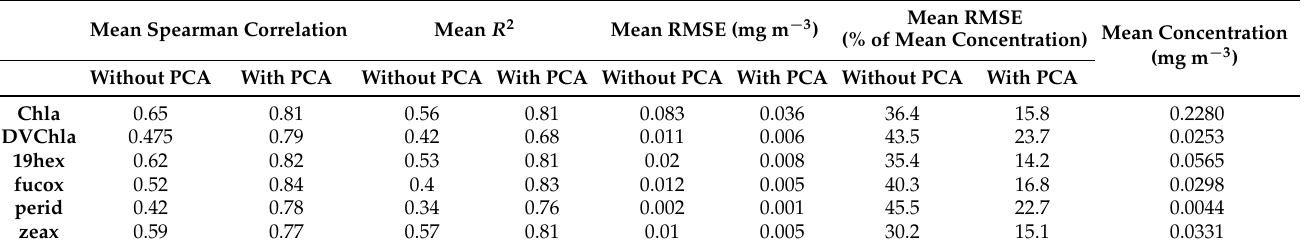
Mean RMSE (% of Mean Concentration) Mean Concentration (mg m − 3 )